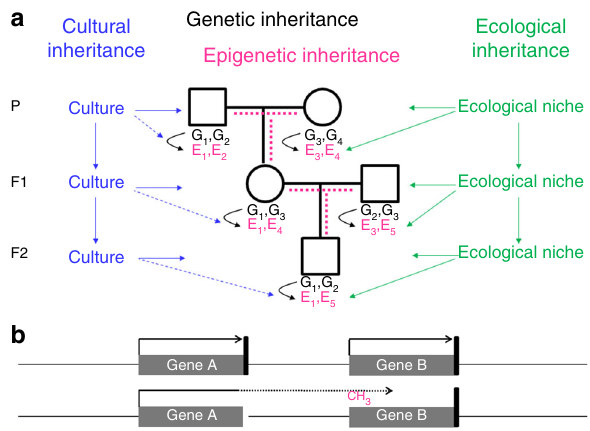
Fig. 1 Transgenerational inheritance systems. a Offspring inherit from their parents genes (black), the environment (green) and culture (blue). Genes and the environment affect the epigenome (magenta) and the phenotype 22 . Culture also affects the phenotype, but at present there is no evidence for a direct effect of culture on the epigenome (broken blue lines). It is a matter of debate, how much epigenetic information is inherited through the germline (broken magenta lines). G genetic variant, E epigenetic variant. b An epimutation (promoter methylation and silencing of gene B in this example) often results from aberrant read-through transcription from a mutant neighboring gene, either in sense orientation as shown here or in antisense orientation. The presence of such a secondary epimutation in several generations of a family mimics transgenerational epigenetic inheritance, although it in fact represents genetic inheritance. Black arrow, transcription; black vertical bar, transcription termination signal; broken arrow, read-through